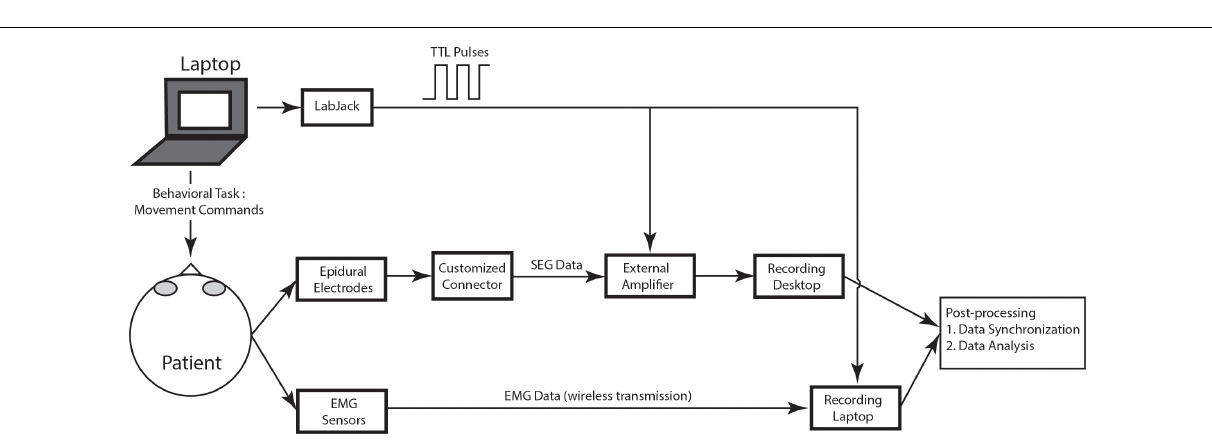
FIGURE 3 | Lead types based on fluoroscopic imaging. An example of a cylindrical (A) and paddle (B) leads are shown using intra-operative fluoroscopic imaging.